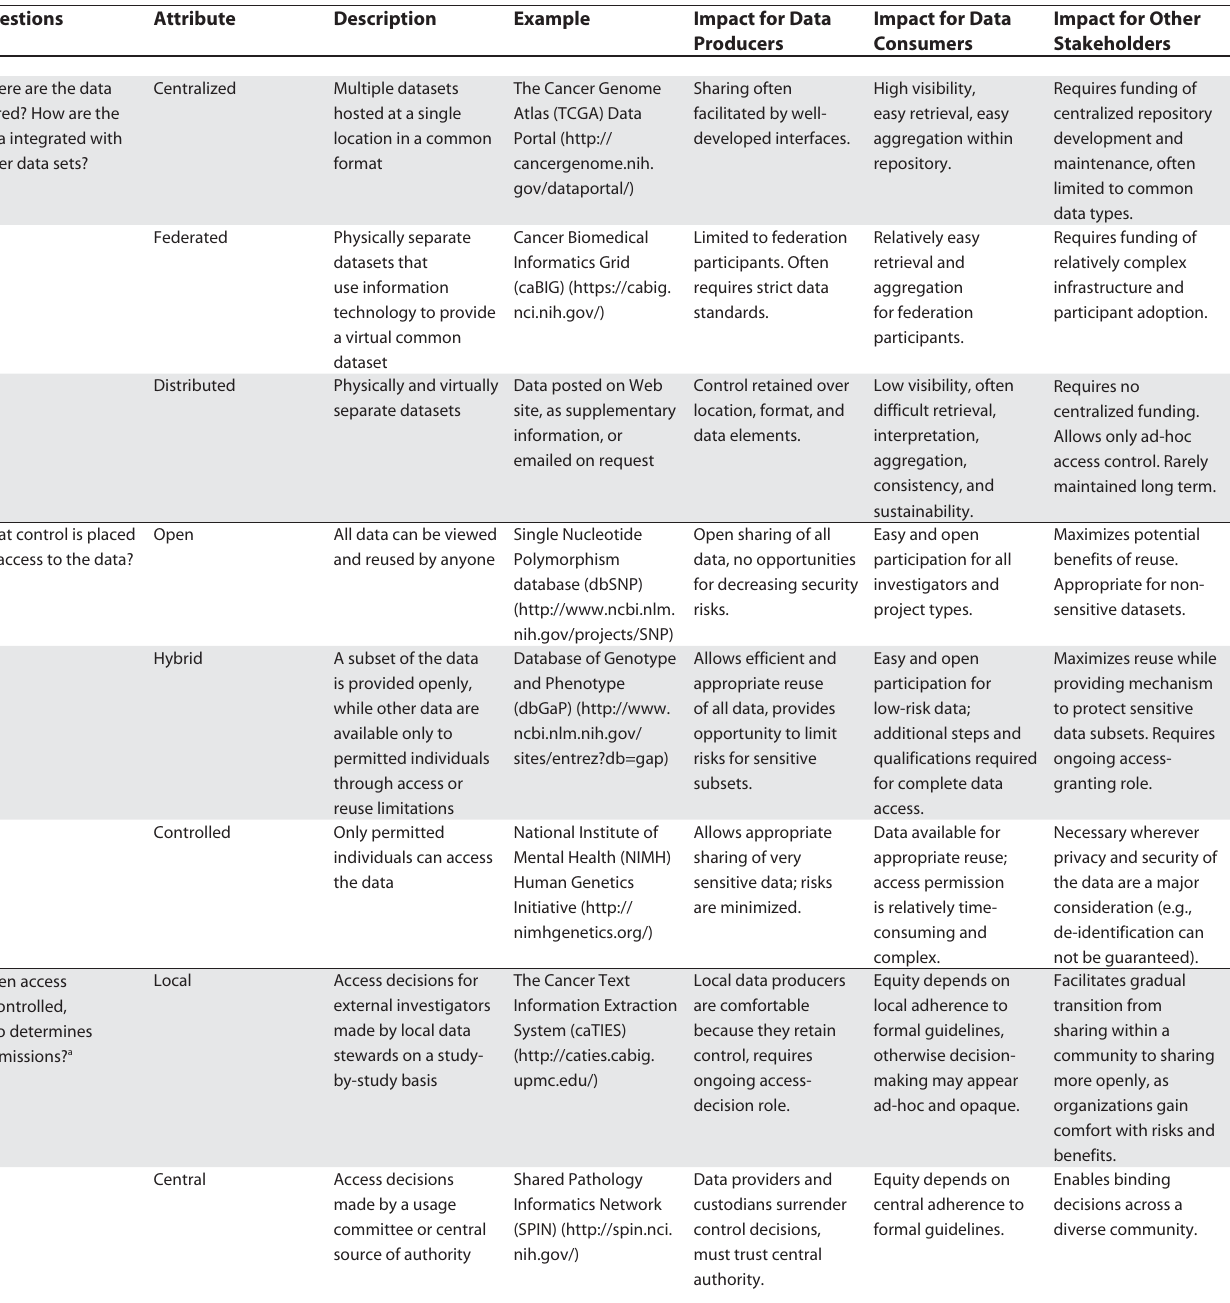
Table 1. Selected Attributes of Example Data Sharing Frameworks and